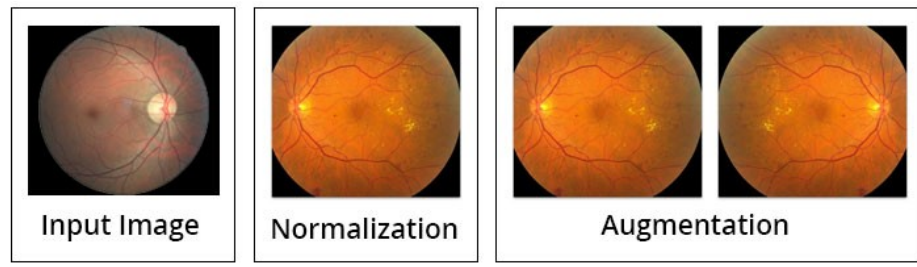
Figure 7. Data preprocessing and augmentation processes [14].